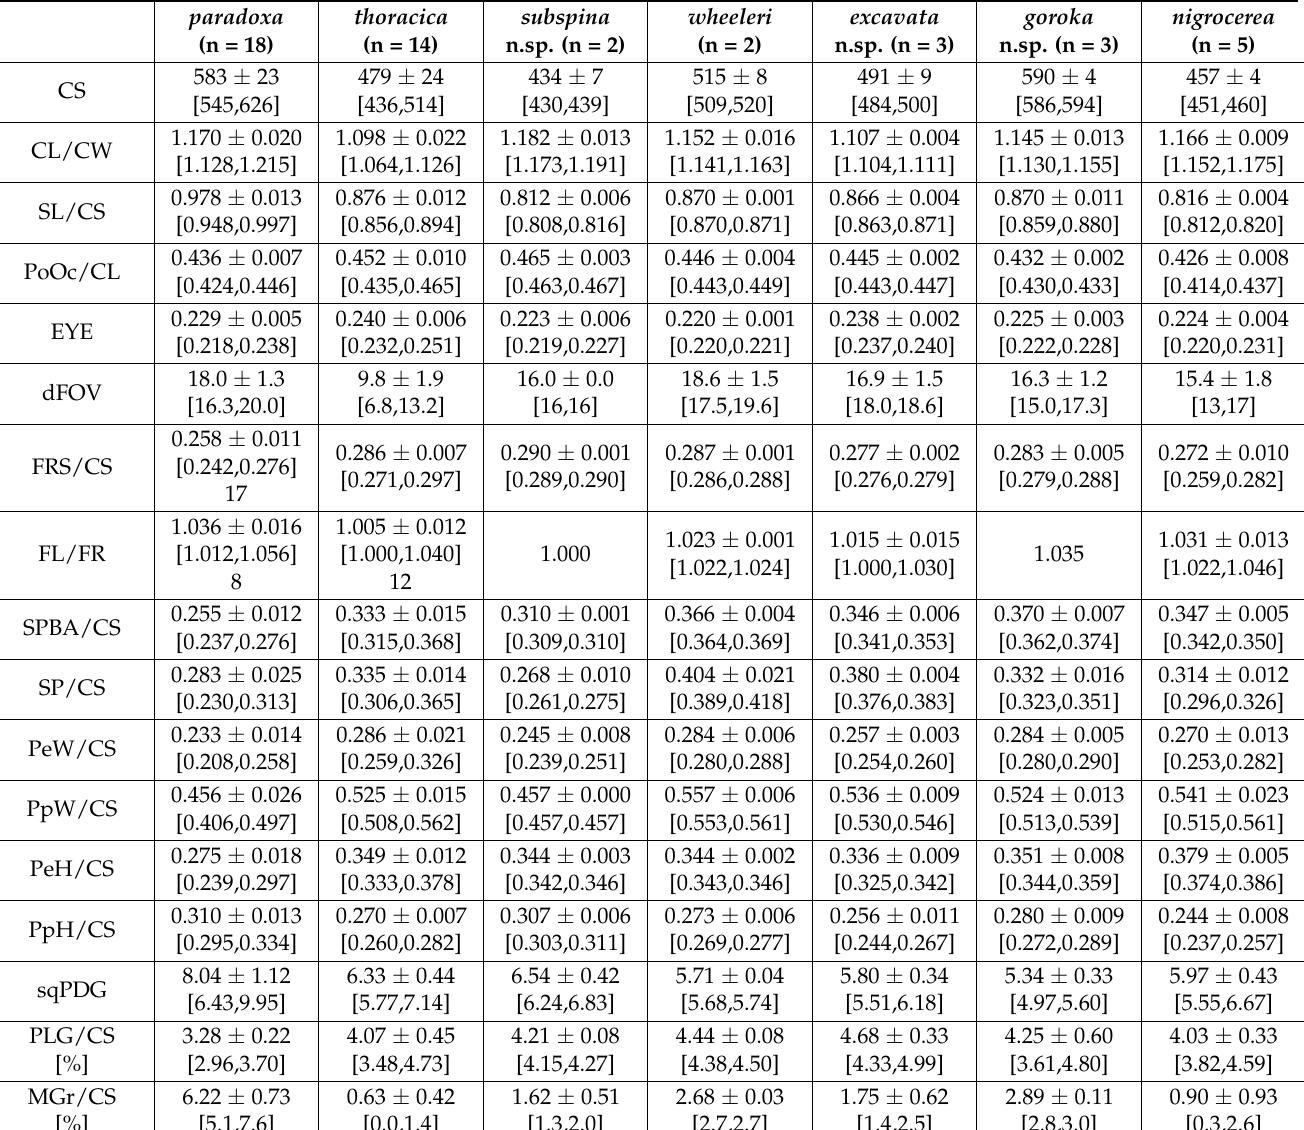
Table 4. Measurements of workers of the C. thoracica and C. wheeleri group. Explanation of data arrangement as in Table